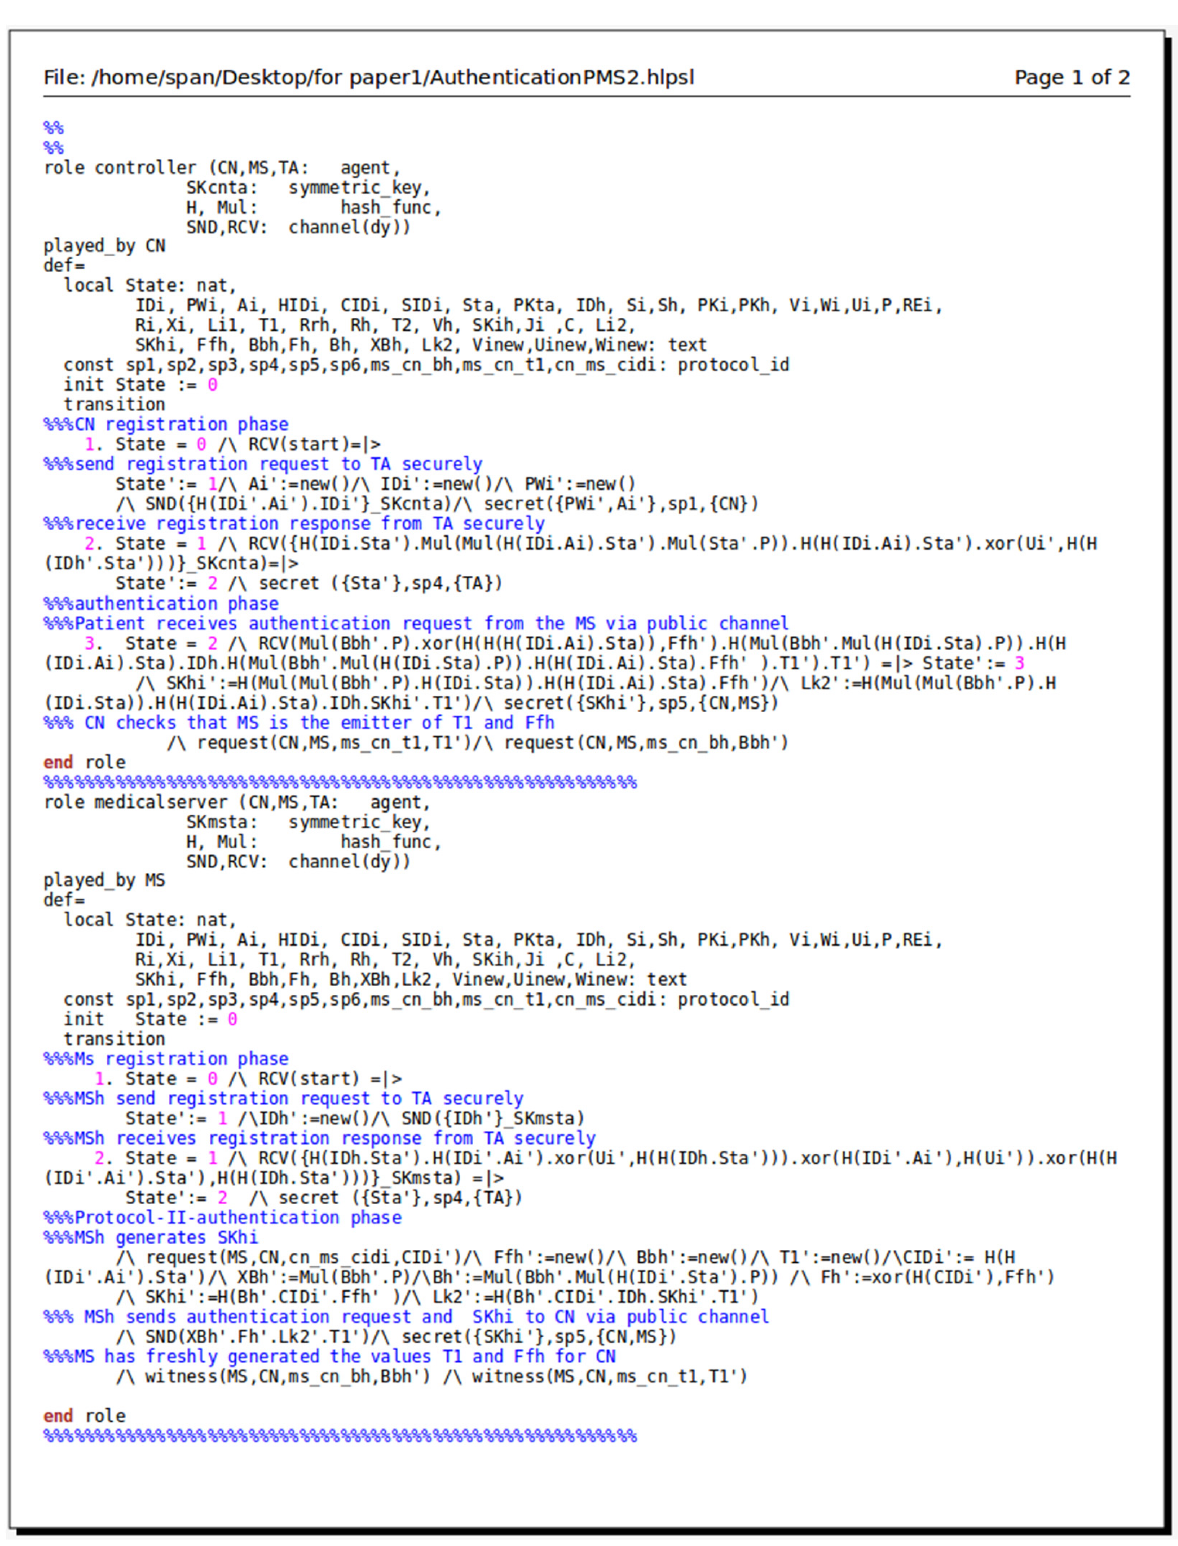
Figure 8. The HLPSL code of P-II.